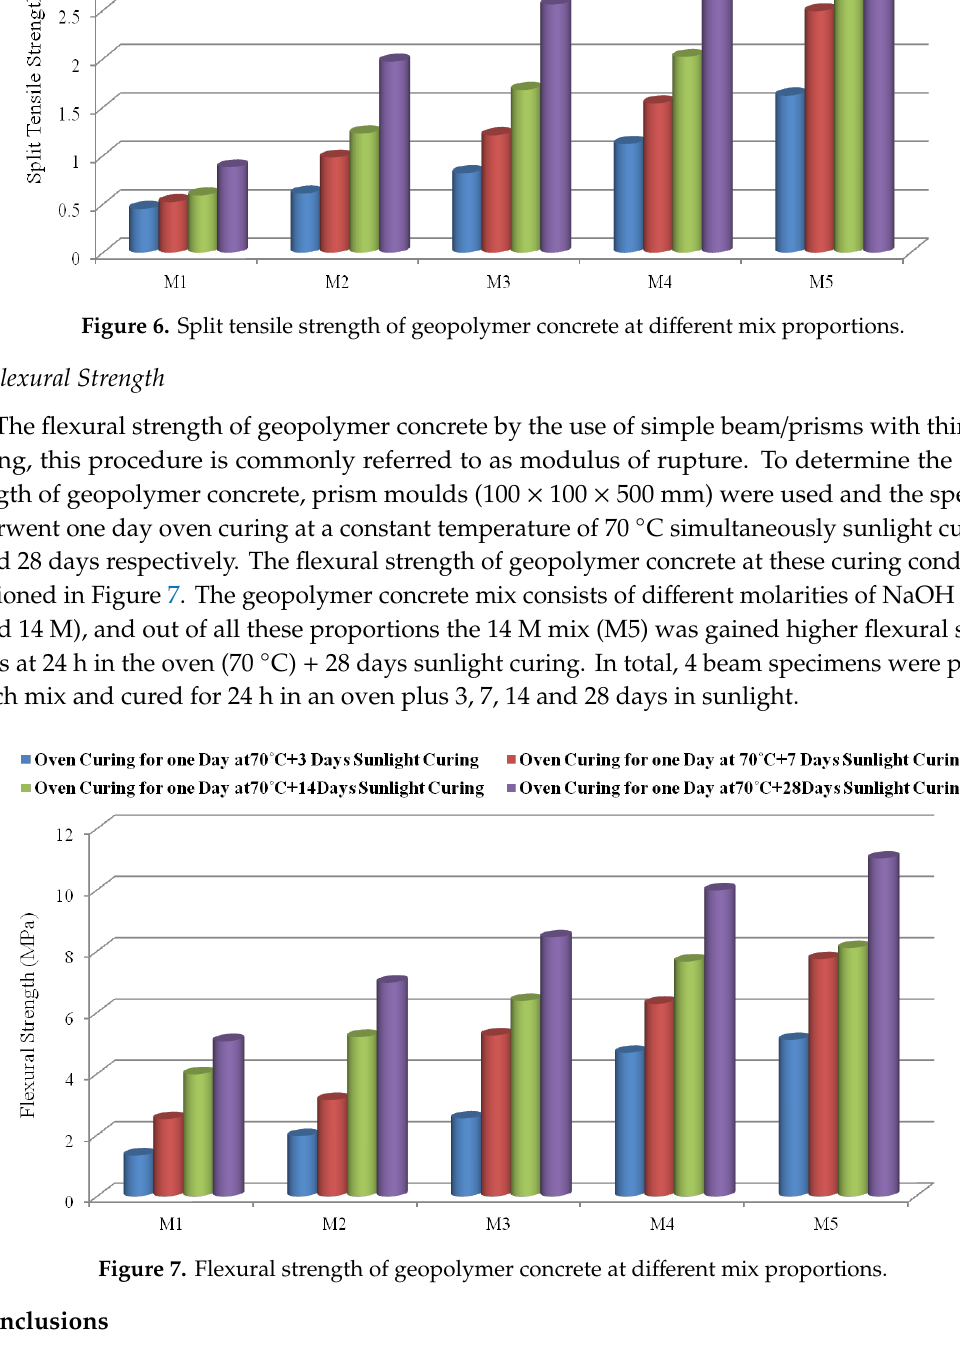
Figure 7. Flexural strength of geopolymer concrete at different mix proportions.